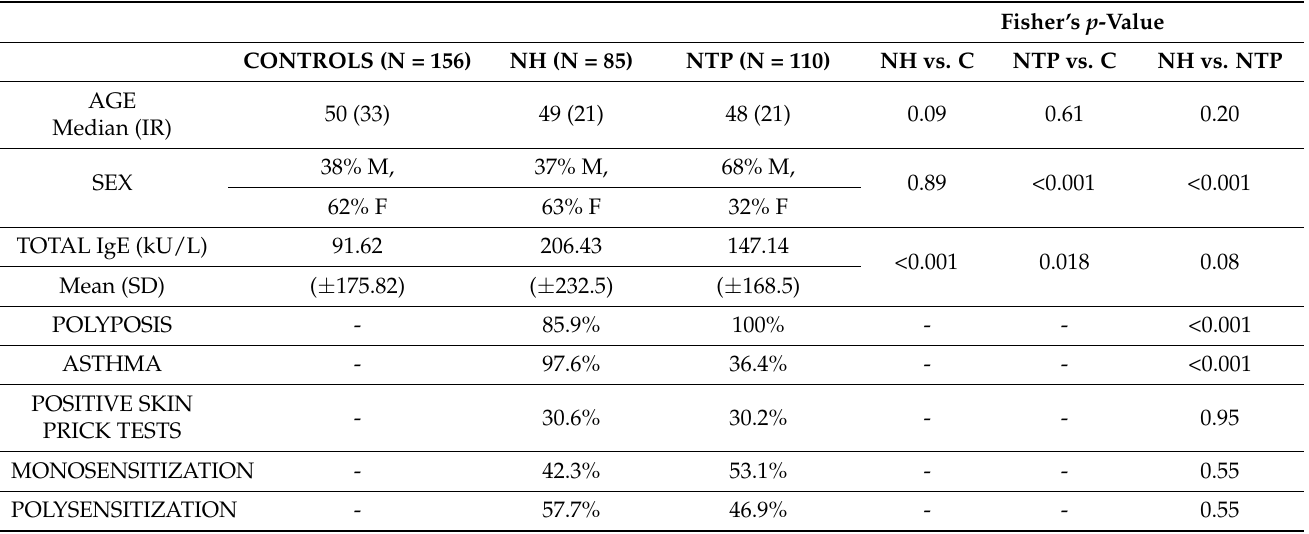
Table 2. Descriptive analysis of patients with NSAID hypersensitivity, NSAID-tolerant patients, and controls.